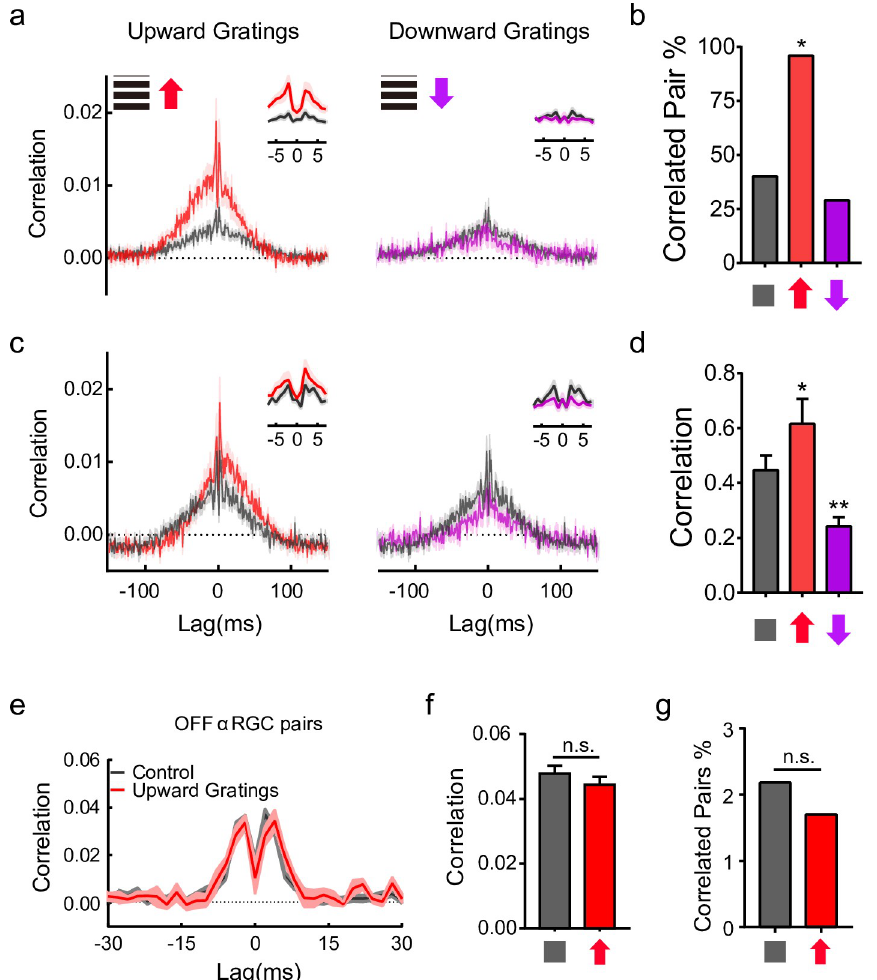
Fig 4. Proportion of correlated pairs and correlation strength are both affected by VME. (a) Average cross- correlogram of V-DSGC pairs at a close distance. Cross-correlograms of all V-DSGC pairs within 250 μ m of each other are averaged. Control, gray, n = 75; upward VME, red, n = 24; downward VME, magenta, n = 38; shaded areas, ± SEM. Insets are close-up views with 1-ms bin size. (b) Proportion of V-DSGC pairs with measurable activity correlation in different groups shown in (a), with the same color codes. Control/upward VME/downward VME: n = 75/24/38 pairs. The proportion of correlated pairs show significant difference between the control group and the upward VME group. Chi-squared test, p = 0.01 for upward VME group, p = 0.48 for downward VME group. (c) The same as in (a), except that, of the V-DSGC pairs represented in (a), only those with significant spike time correlation are used for averaging. Control, gray, n = 30; upward VME, red, n = 23; downward VME, magenta, n = 16; Shaded areas, ± SEM. (d) Quantification of correlation strength from cross-correlograms in (c), computed as described in 2d. �� p < 0.01, � p < 0.05, unpaired t test. Error bars, SEM. (e, f, g) Comparison of the gap junction connections between OFF α RGC pairs. (e) Average cross-correlograms of all correlated OFF α RGC pairs. (f) Quantification of total correlation strength based on (e). The sum of the spike time cross-correlation in (e) from − 15 ms to +15 ms is used for comparison. No significant change in the strength of correlation can be detected, p = 0.52, unpaired t test. (g) Proportion of correlated OFF α RGC pairs show no difference between control and upward VME. Chi-squared test, p = 0.53. Control, gray, n = 45 pairs; upward gratings VME, red, n = 11 pairs. Shaded areas, ± SEM. Data for this figure are in S4 Data. α RGC, alpha retinal ganglion cell; V-DSGC, ventral-preferring direction selective ganglion cell; VME, visual motion